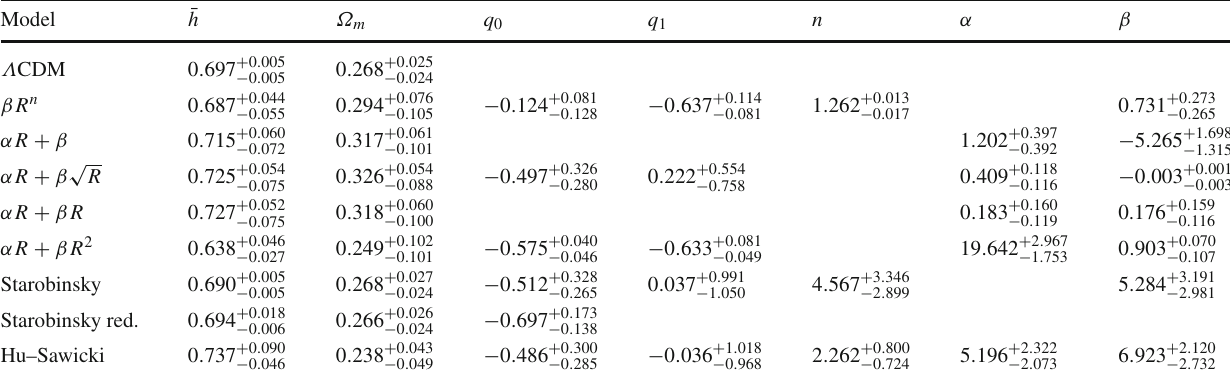
Table 1 The MCMC simulation best fitting parameters values for each tested model, including the Λ CMD model. The models are listed in the order that was given at the start of Sect.